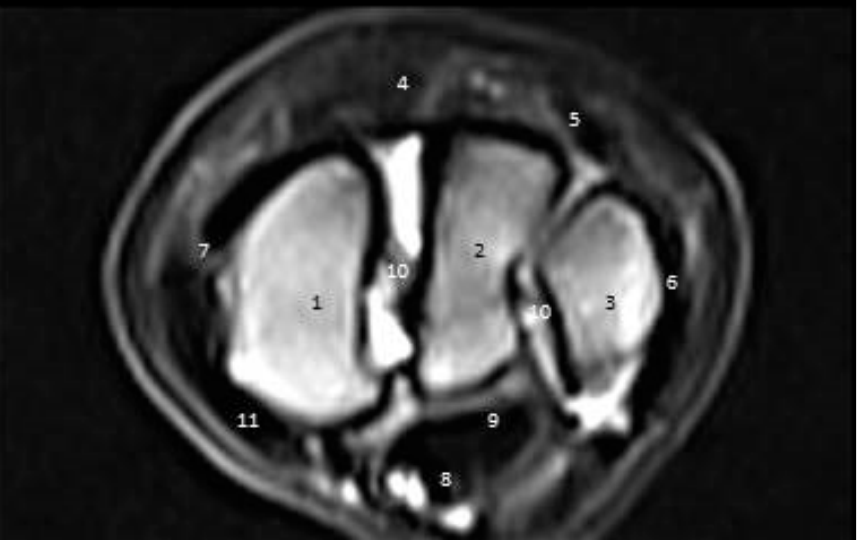
Figure 9. A cross-sectional magnetic resonance imaging scan of the carpal joint in donkeys at the level of the second row of carpal bones. (1) Second carpal bone. (2) Third carpal bone. (3) Fourth carpal bone. (4) Extensor carpi radialis tendon. (5) Mutual digital extensor. (6) Lateral collateral liga- ment. (7) Medial collateral ligament. (8) Superficial digital flexor tendon. (9) Deep digital flexor tendon. (10) Transverse intercarpal ligaments in the proximal and distal rows of carpal bones. (11) Carpal